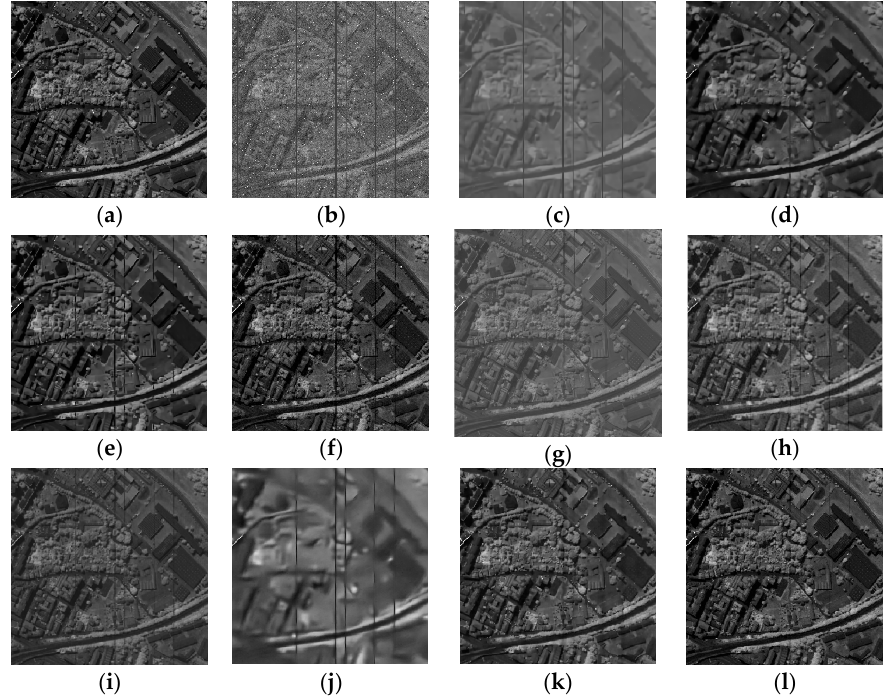
Figure 7. Restored results of band 90 corrupted with mixed noises: ( a ) clean HSI; ( b ) noisy HSI; ( c ) BM3D; ( d ) ANLM3D; ( e ) BM4D; ( f ) LRMR; ( g ) GLF; ( h ) LRTDTV; ( i ) LTDL; ( j ) DnCNN; ( k ) HSID-CNN; ( l ) VLRMFmcl.